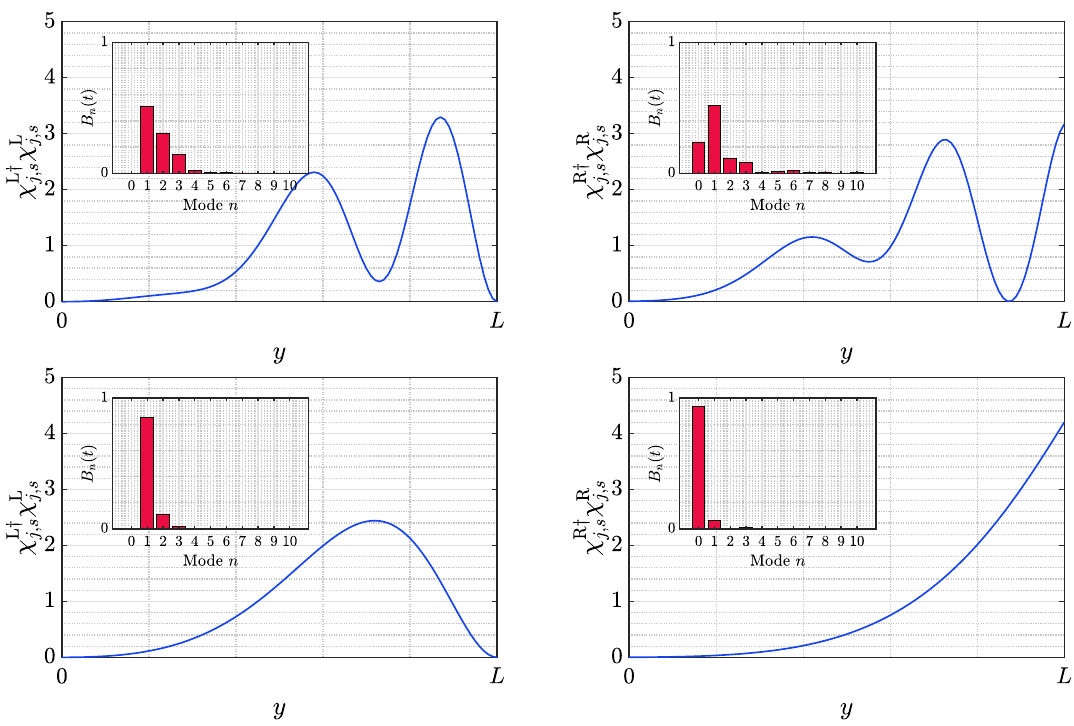
3 . The inset is = 50 L and the =